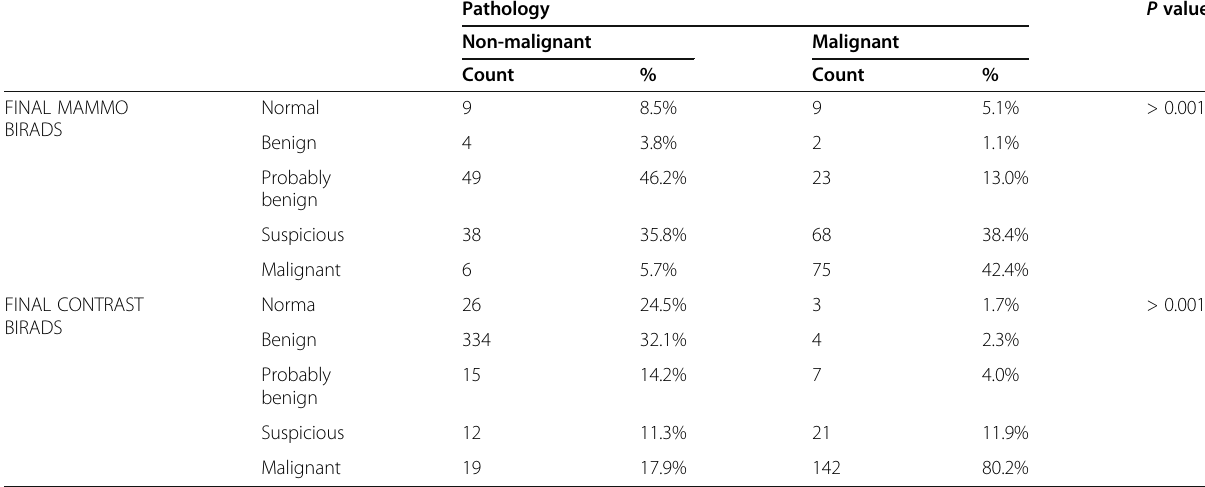
Table 3 The final BIRADS of conventional versus contrast-enhanced mammography in correlation with final pathology